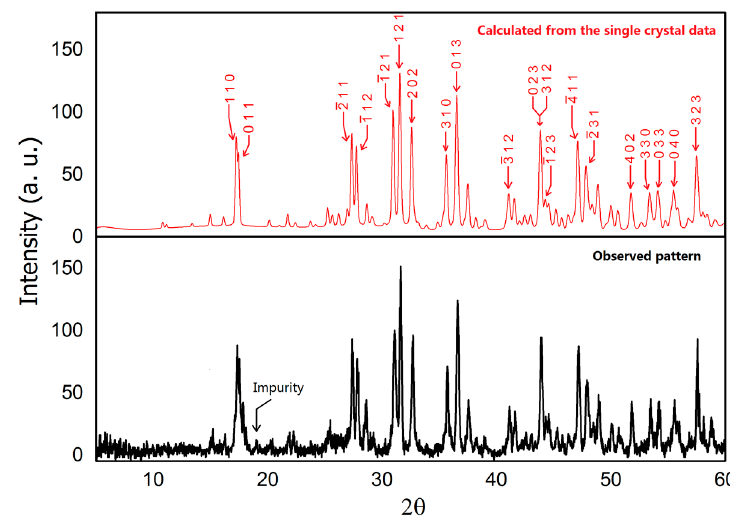
Figure 1. Powder X-ray diffraction pattern of BaIr 2 Ge 2 (Cu K α radiation, 300 K). Lower—observed pattern; Upper—calculated pattern with marked Miller indices (hkl) based on the single crystal structure.